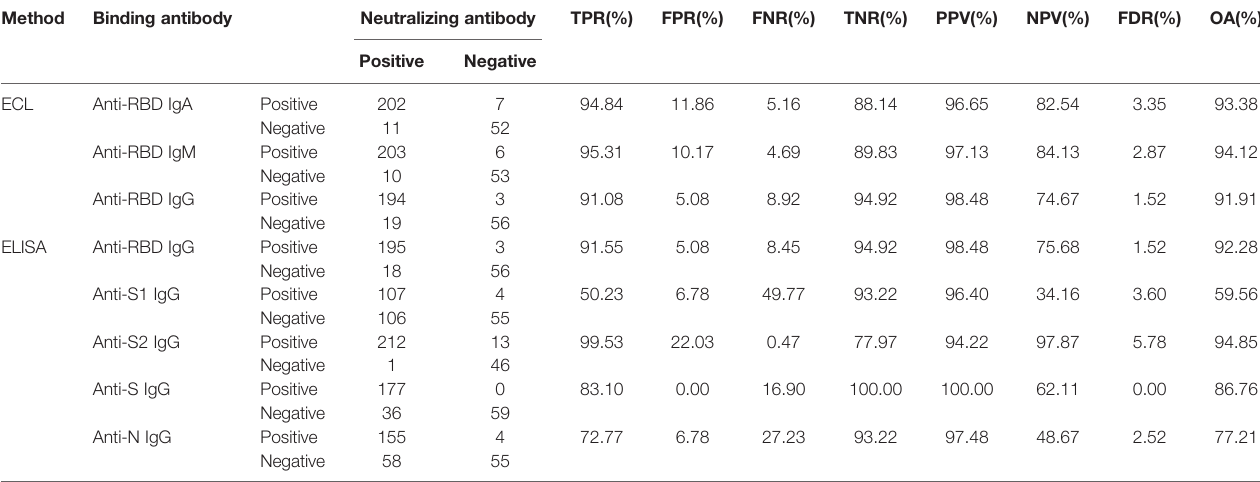
TABLE 2 | Overall performance of binding antibodies for predicting neutralizing antibodies. Method Binding